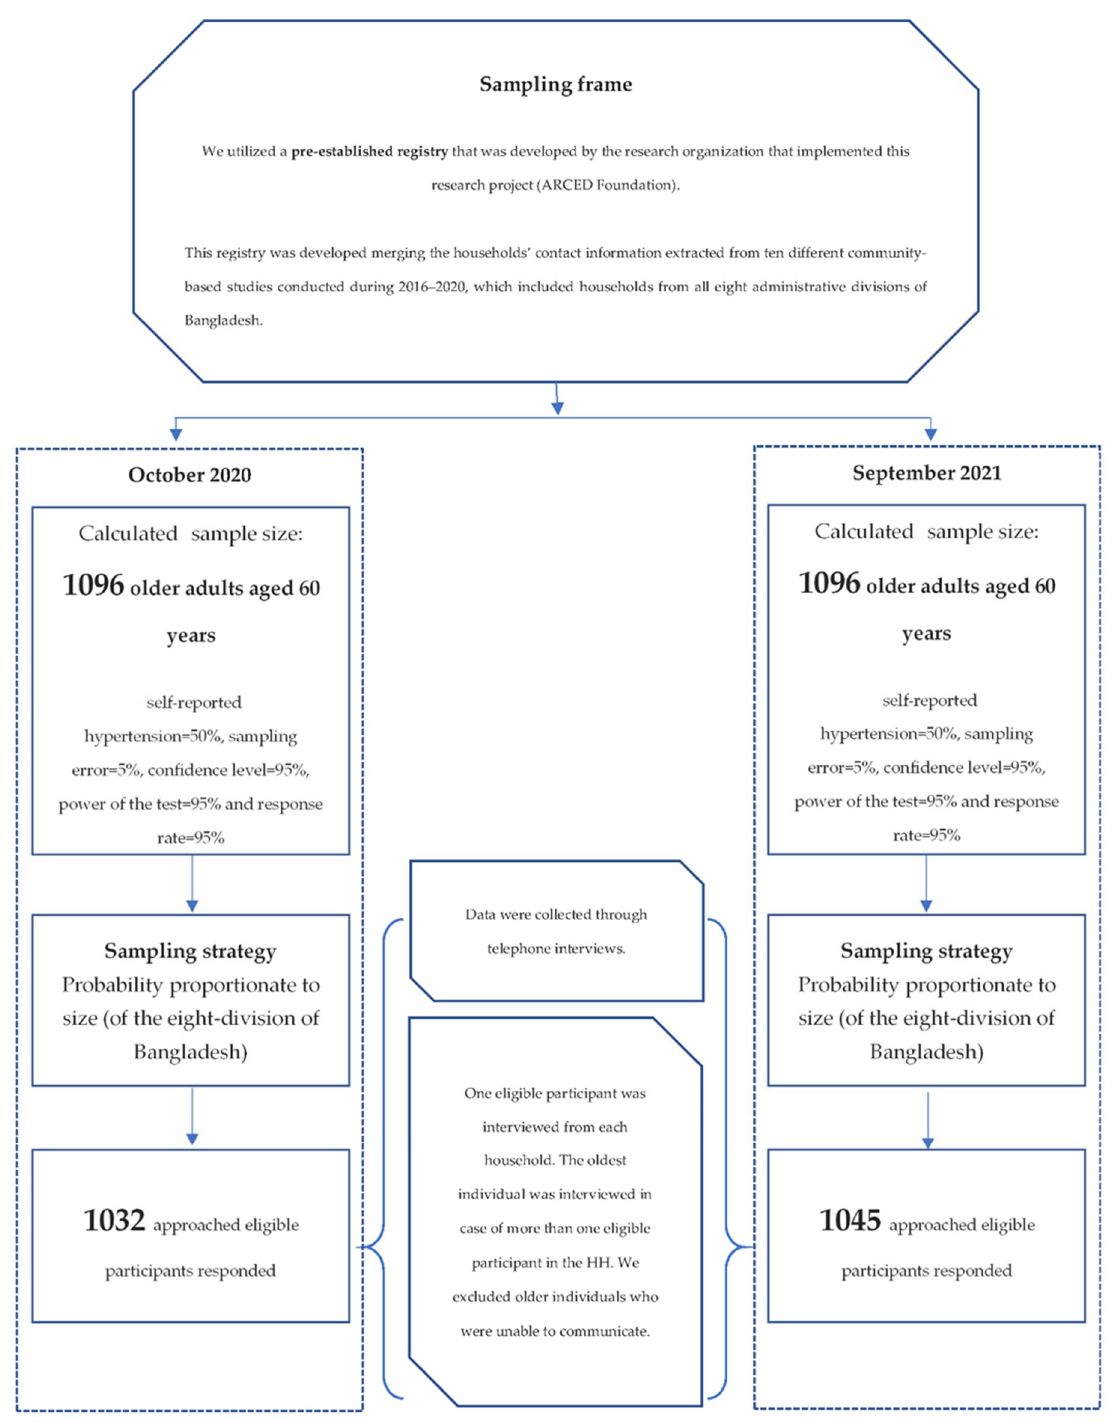
Figure 1. Sampling strategy and participants